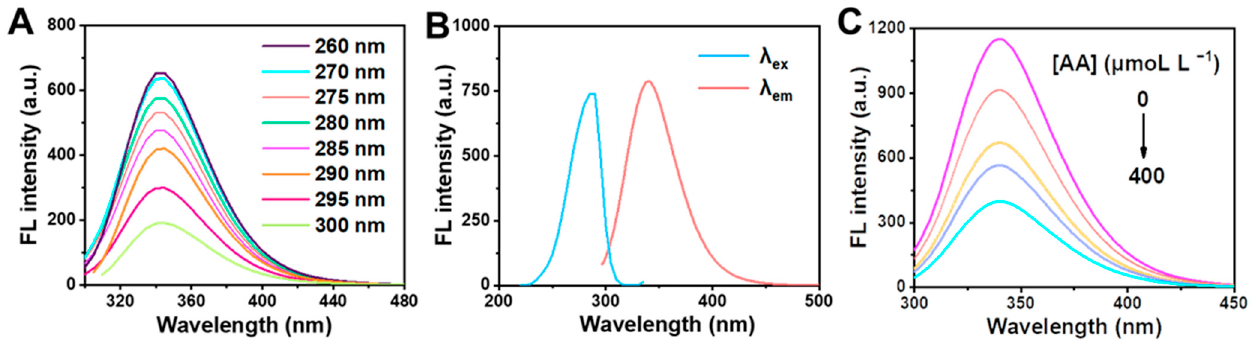
Figure 1. ( A ) Fluorescence emission spectra of BSA at different excitation wavelengths. ( B ) Fluorescence excitation ( λ em = 340 nm) and emission ( λ ex = 288 nm) spectra of BSA. ( C ) Fluorescence emission spectra of system containing various concentration of AA (0, 40, 100, 200 and 400 μ mol L − 1 ).